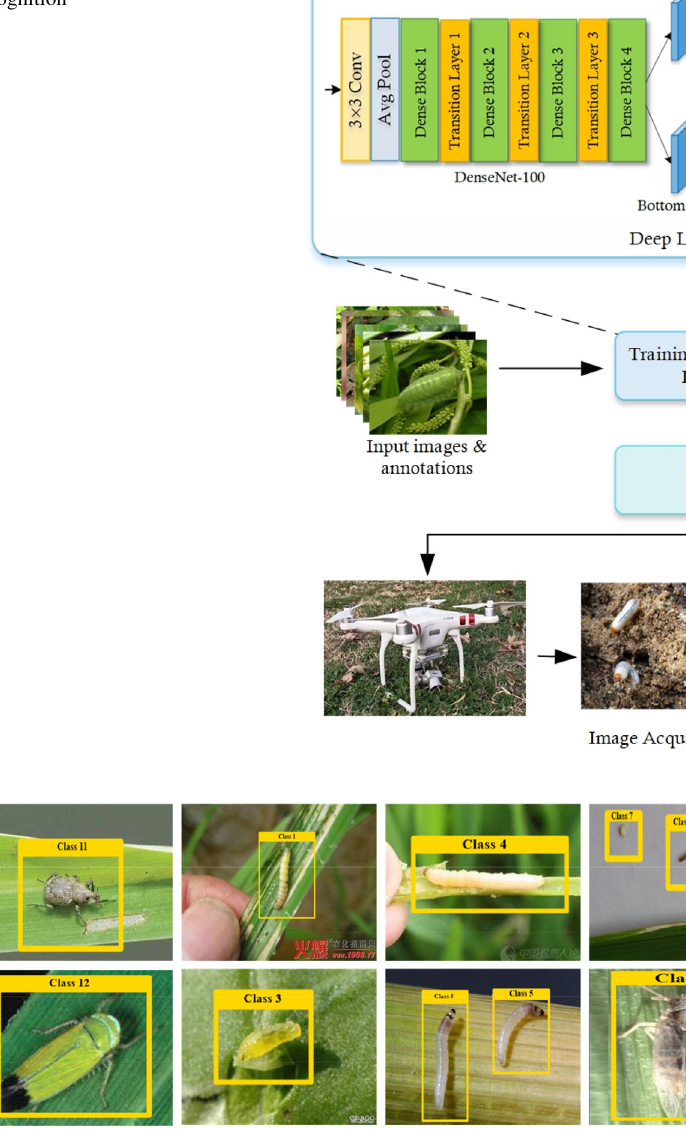
Fig. 1 Visual representation of the introduced approach for pest recognition